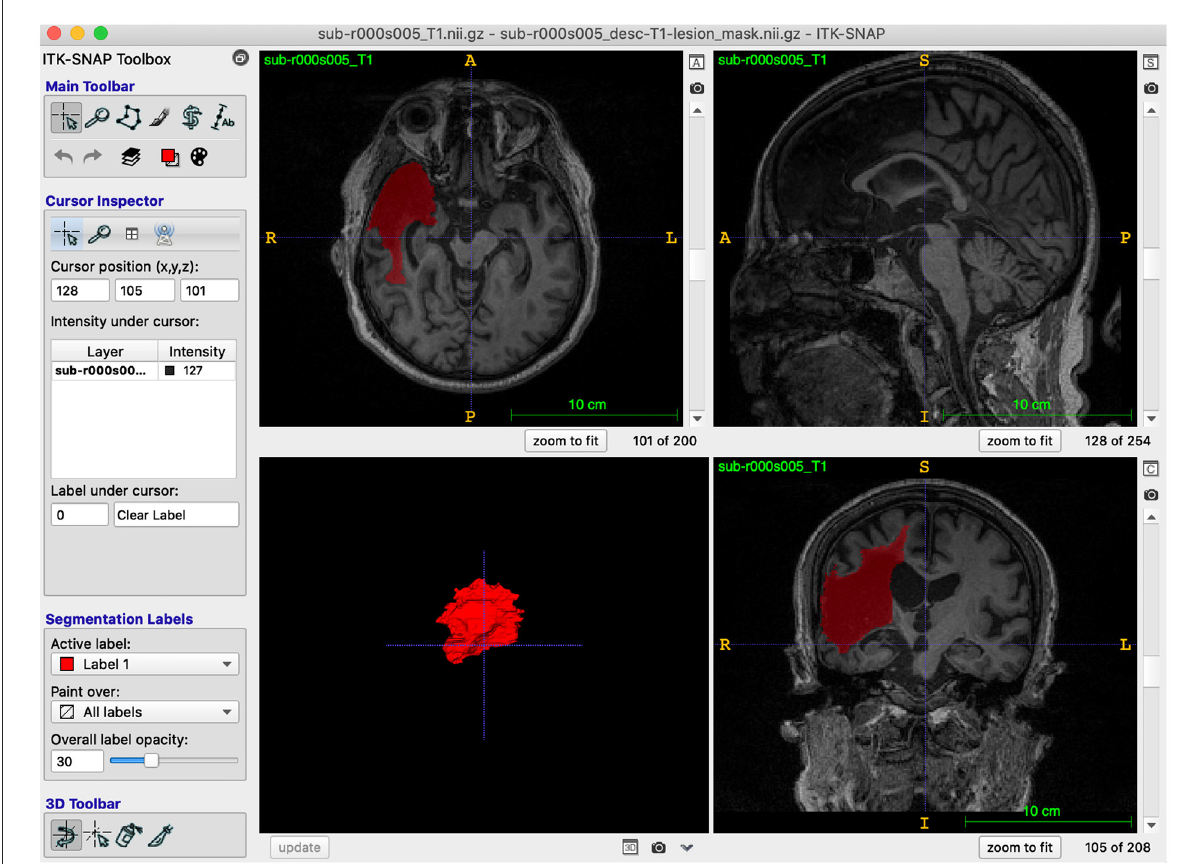
FIGURE2 ITK-SNAP software: A screenshot example of the ITK-SNAP interface, demonstrating all three anatomical views and a 3D rendering of the traced segmentation.